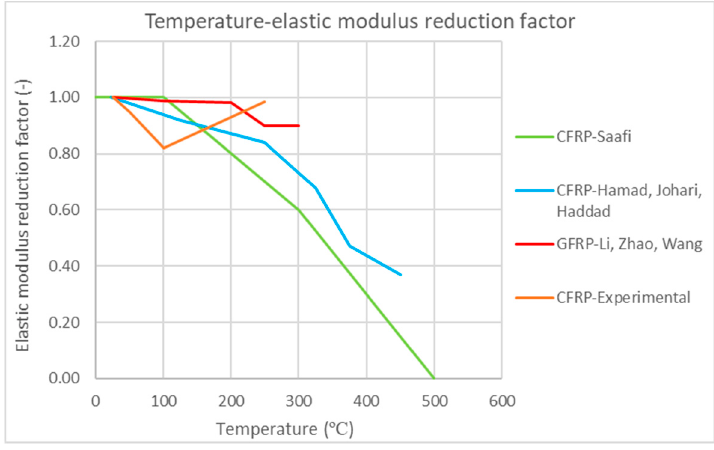
Figure 23. Temperature–elastic modulus reduction factor curves [18,23,30].